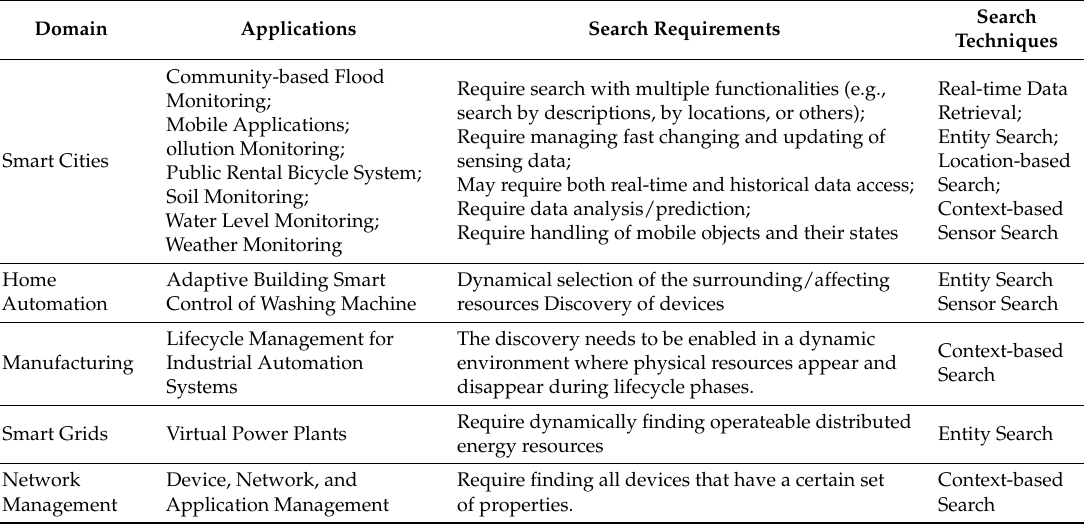
Table 1. WoT Applications and Enabling Search